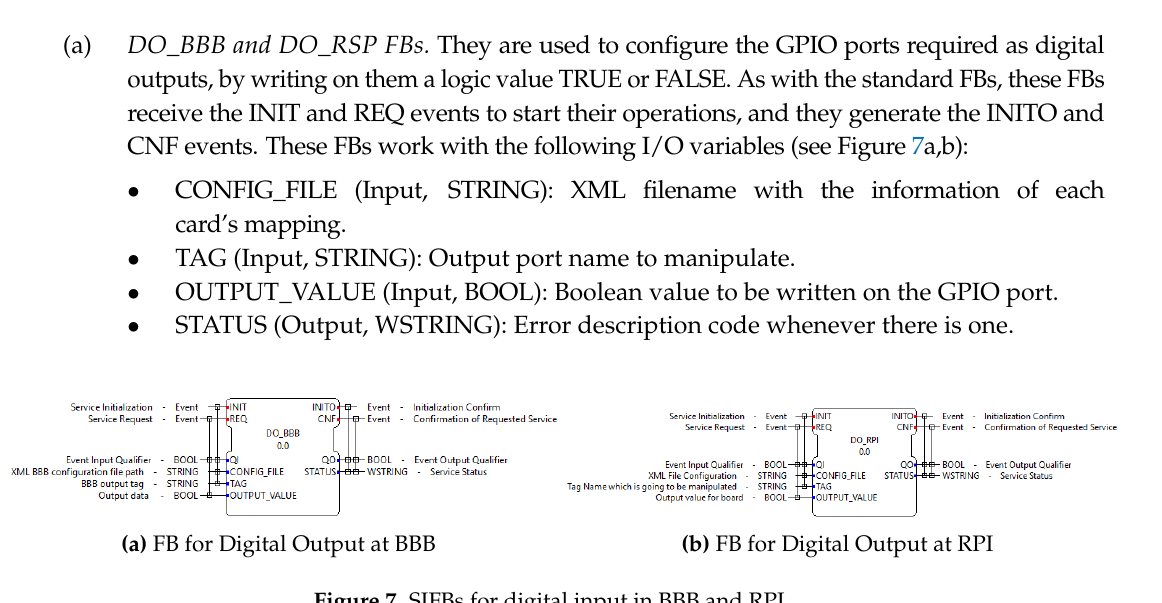
Figure 7. SIFBs for digital input in BBB and